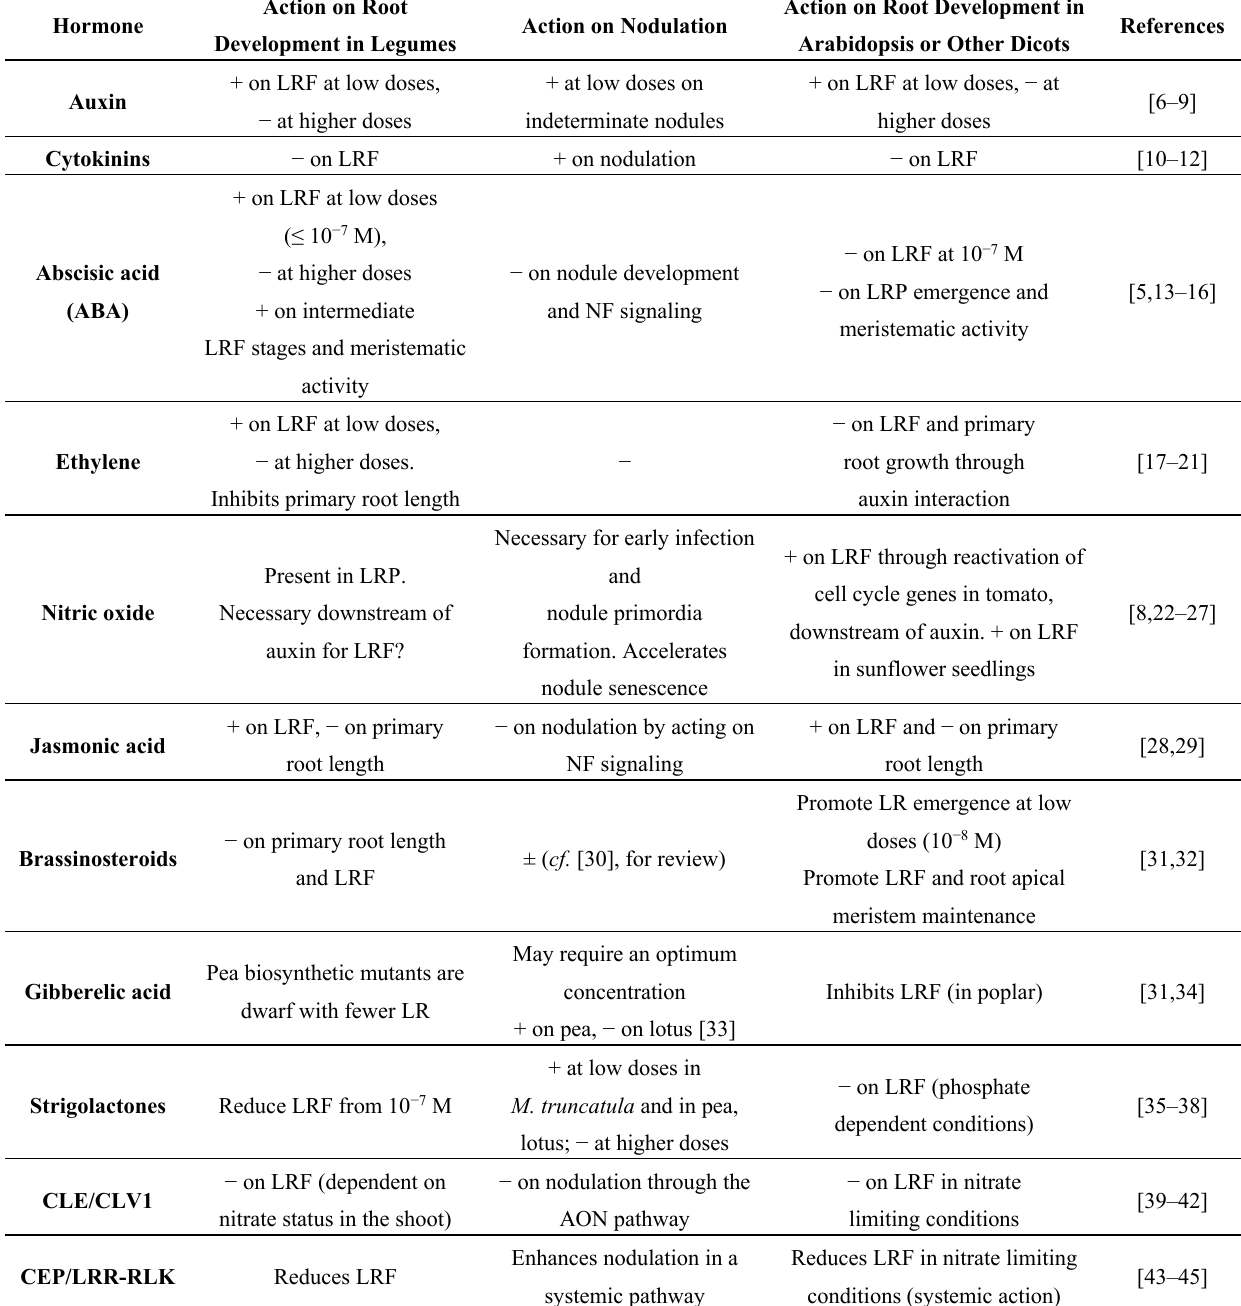
Table 1. Summary of the action of the main phytohormones on root development and nodulation in legumes and root development in Arabidopsis or other non-legume dicot species (when